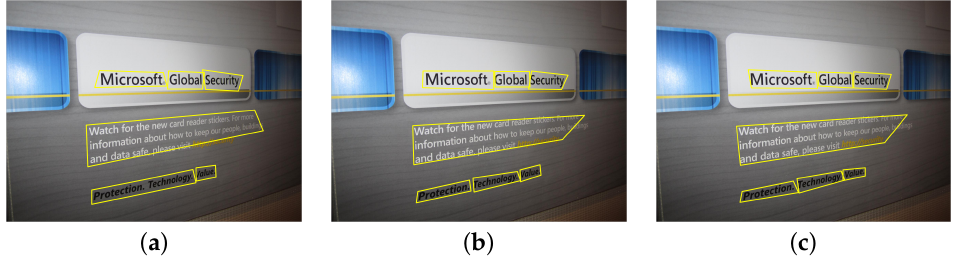
Figure 5. MobileTDNet text detection for an example: ( a ) shows detection without text attention blocks, average IoU = 0.859; ( b ) shows detection with Text Attention 1 block, average IoU = 0.873; ( c ) shows detection with Text Attention 1, 2 and 3 blocks, average IoU = 0.881.